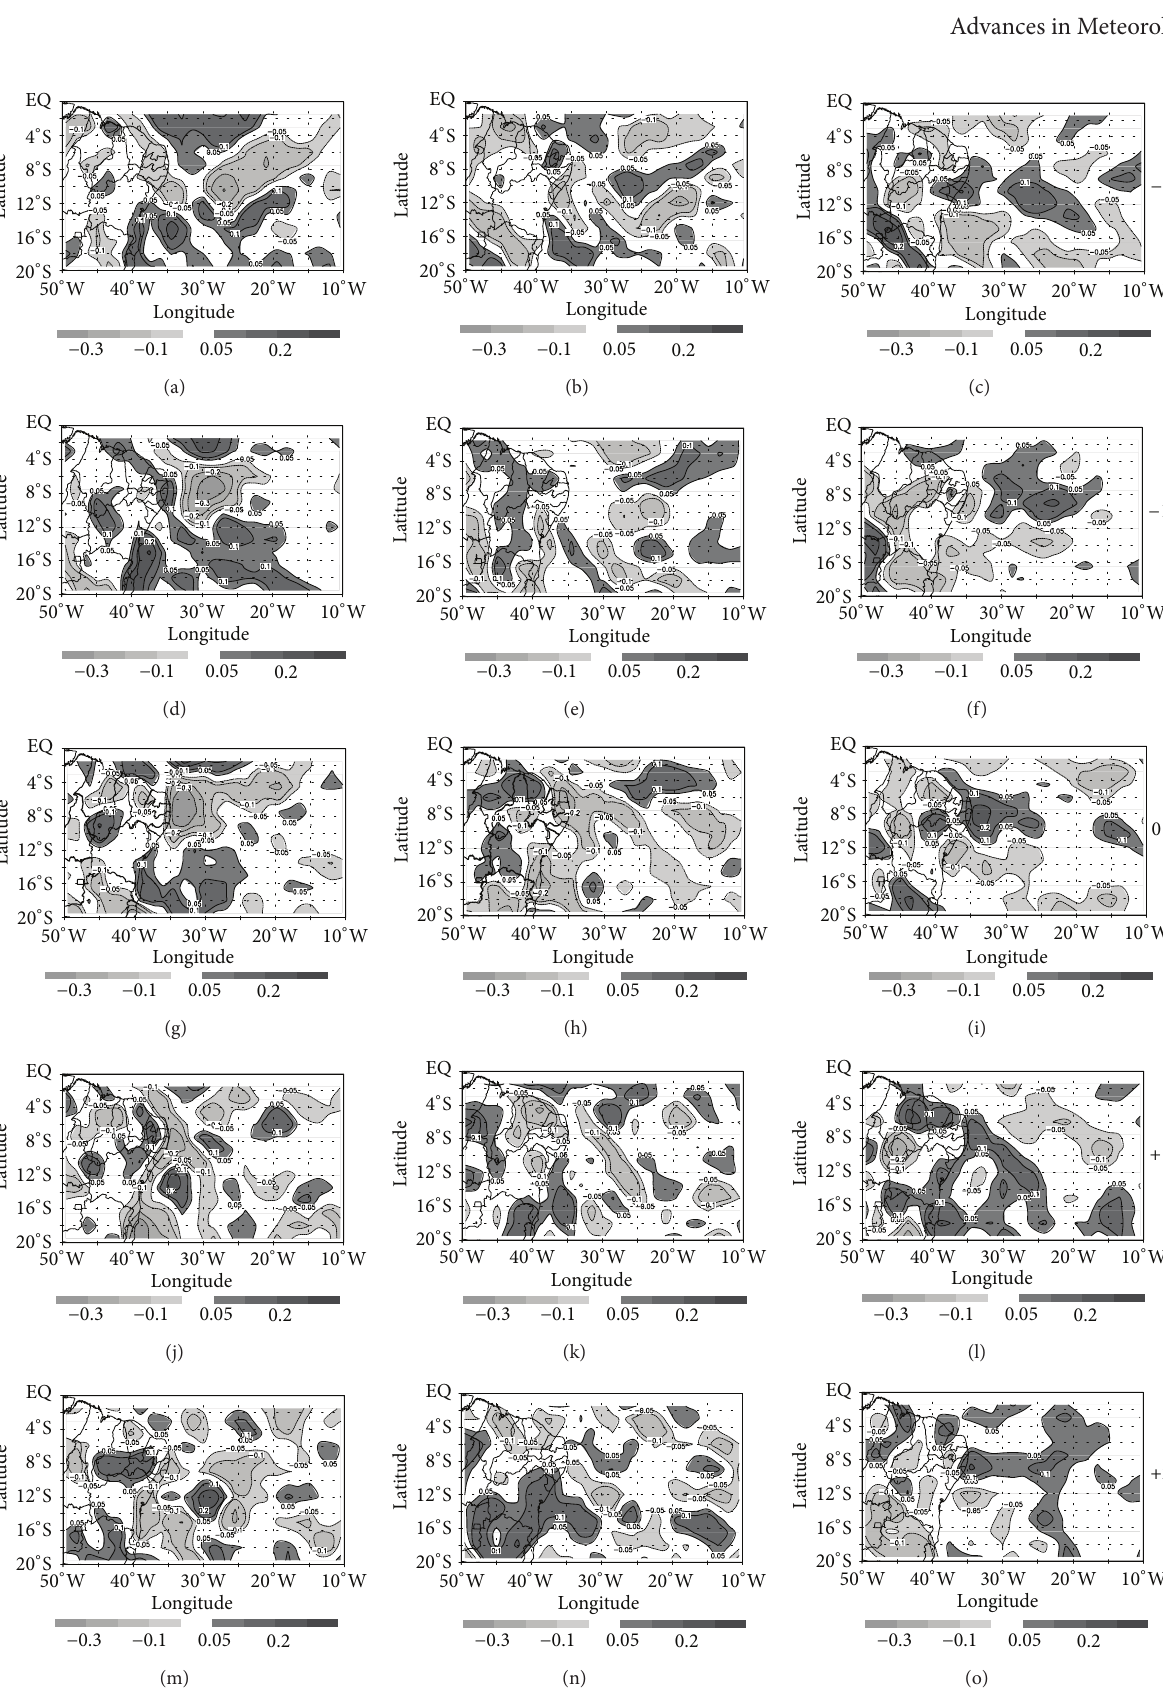
Figure 7: As in Figure 6, but for the horizontal divergence (10 −5 s −1